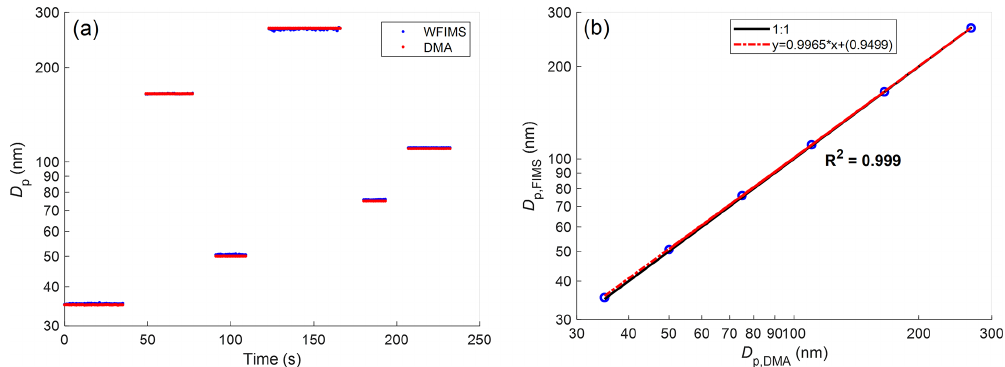
Figure 3. (a) Time series of mean diameters measured by WFIMS at an RH of 20% and DMA-selected sizes. (b) Scatterplot comparing DMA-selected particle size and WFIMS measured particle size and linear regression.